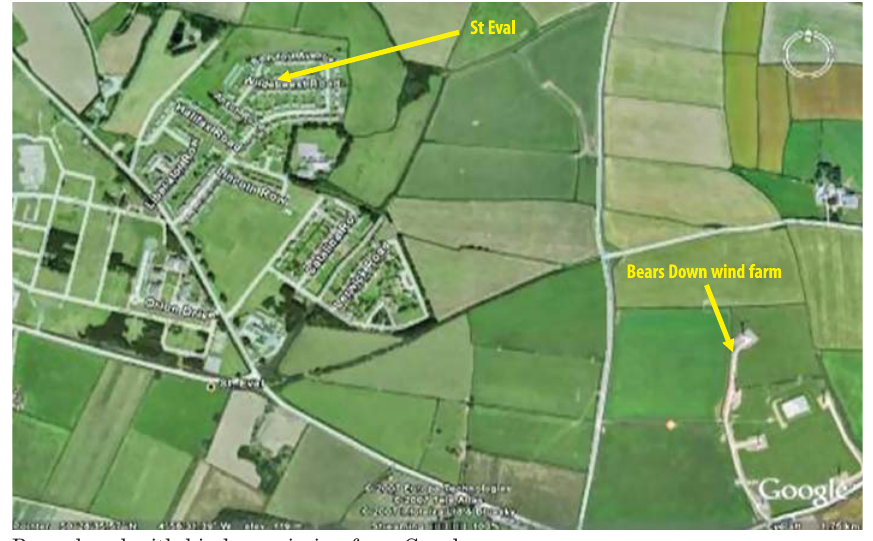
Reproduced with kind permission from Google Figure 5. GIS view of the location of St Eval and Bears Down